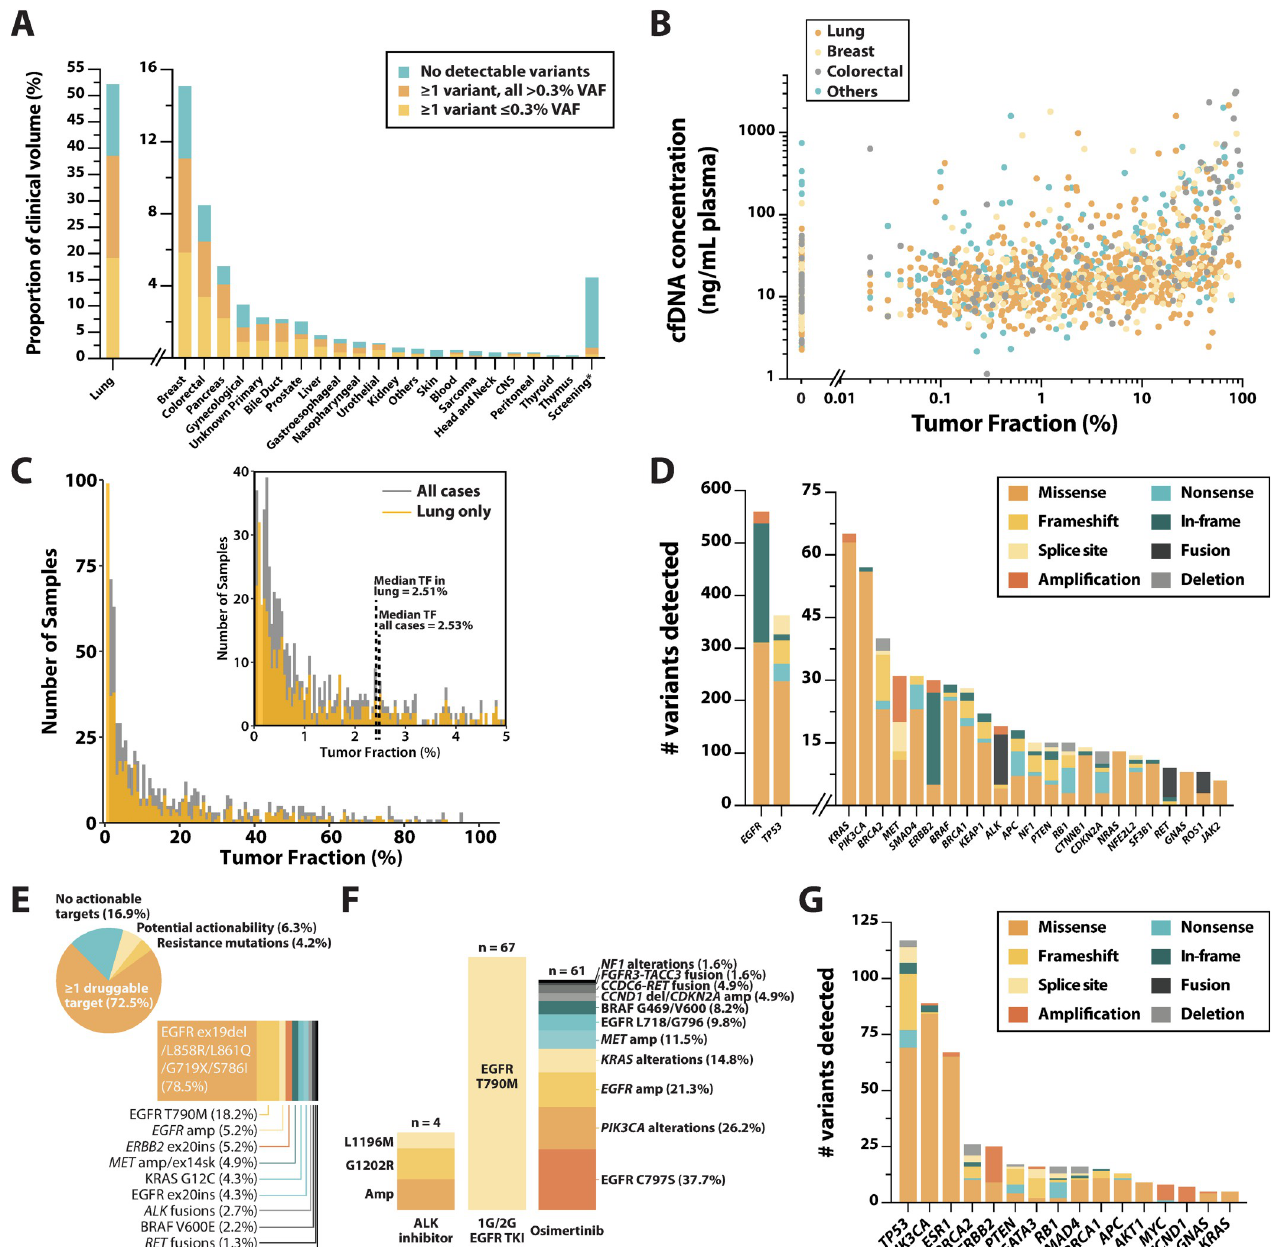
Fig 5. Clinical utility of the LiquidHALLMARK assay. (A) Proportion of clinical volume (n = 1,592) by tumor origin. Samples with no detectable variants are shaded in blue, while positive samples are shaded in yellow if at least 1 variant was detected at a variant allele frequency (VAF) � 0.3% and orange if all variants detected were > 0.3% VAF. CNS, central nervous system. � Screening includes suspected cancer cases. (B) Correlation between cell-free DNA (cfDNA) concentration and tumor fraction, approximated as the variant with the highest VAF observed in any given sample. Lung, breast, and colorectal cancer samples are highlighted in orange, yellow and gray respectively; all other tumor types are highlighted in blue. (C) Distribution of positive samples by tumor fraction. The distribution for positive lung cancer samples is shown in yellow. (D) Prevalence and variant type of the top 25 genes altered in lung cancer samples. Each color represents a different variant type. ( E , top) Proportion and breakdown of 615 ctDNA-positive lung cancer samples with druggable targets. ( E , bottom) Prevalence and breakdown of druggable targets in lung cancers with guideline-approved biomarkers. ( F ) Prevalence and breakdown of alterations associated with resistance observed in lung cancer patients treated with an ALK inhibitor, 1 st or 2 nd generation (1G/2G) EGFR tyrosine kinase inhibitor (TKI), or osimertinib. Ex20ins, exon 20 insertion; ex14sk, exon 14 skipping; amp, amplification; del, deletion. ( G ) Prevalence and variant type of the top 15 genes altered in breast cancer samples. Each color represents a different variant